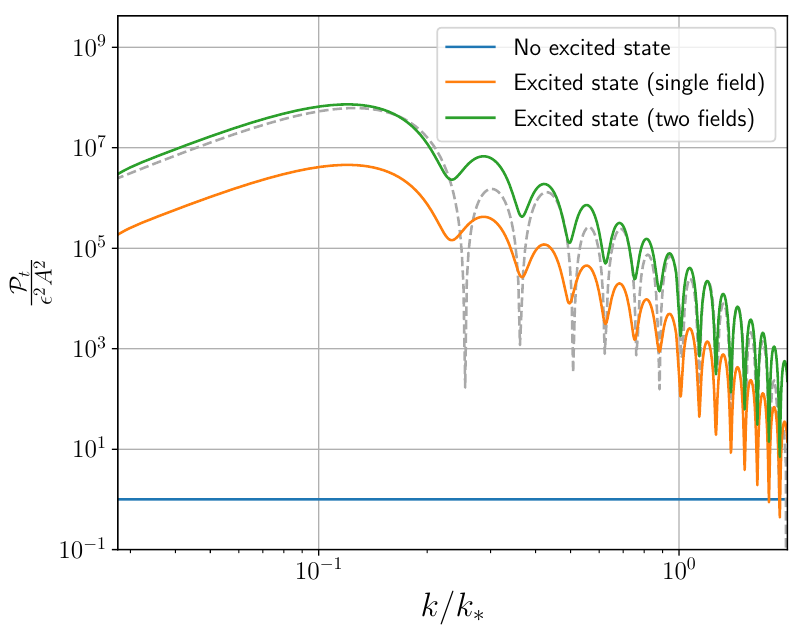
Figure 4 . Enhancement of P t boosted by an excited scalar state normalised to the naive expectation ∼ (cid:15) 2 A 2 , where A is an estimate of the strength of the primordial scalar power spectrum P ζ — see eq. (4.43). The orange and green curves are computed with the Bogoliubov coefficients in section 4.7 with parameters ( η ⊥ , δ ) = (28 , 0 . 25) for a single field or a two fields scenario respectively. In the latter case, P t is enhanced by an extra factor N 4 ∼ 16 as expected. The grey dashed line labels the analytical approximation in eq.